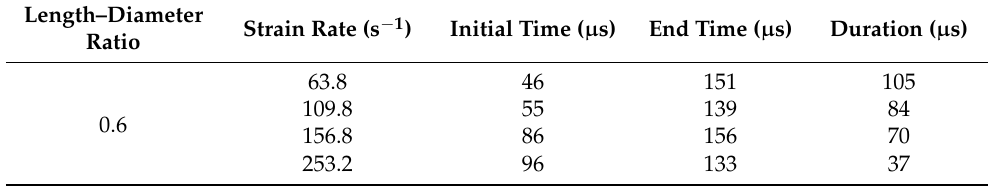
Table 2. Stress equilibrium